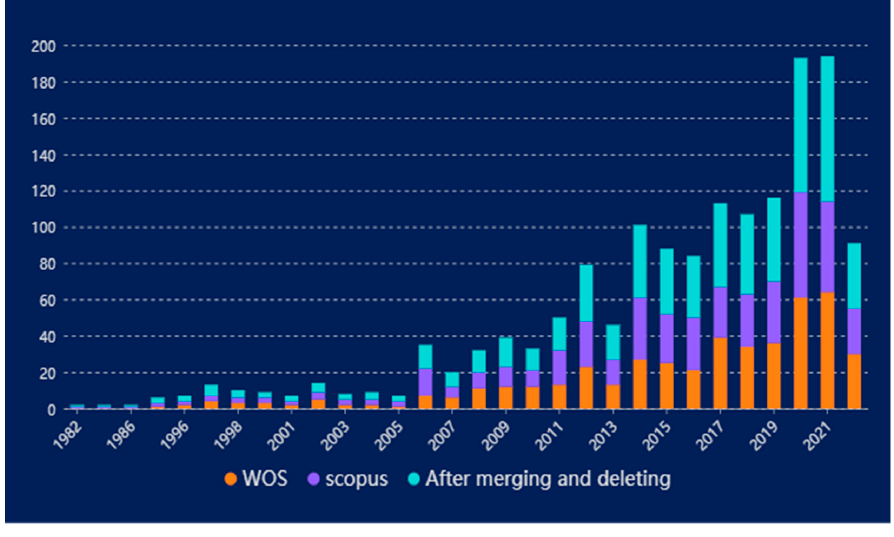
Figure 2. Publication time statistics.